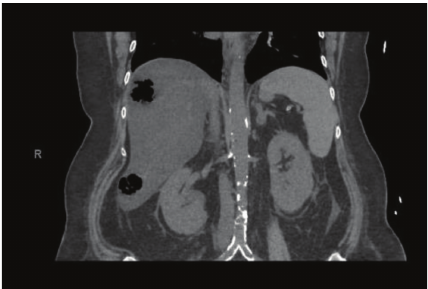
Figure 1: CT abdomen/pelvis demonstrating multiple abscesses in the liver with air fluid